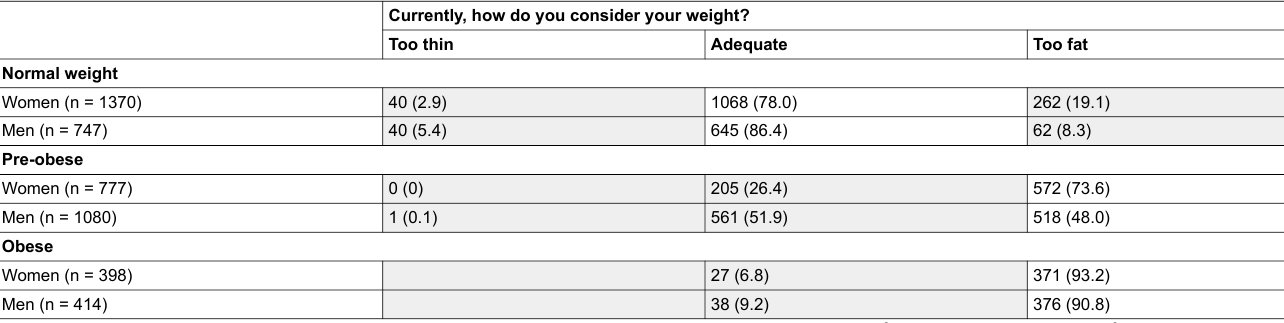
Table 2: Distribution of weight under- or overestimation according to gender and body mass index category, CoLaus study, Lausanne, Switzerland, 2009–2012. Currently, how do you consider your